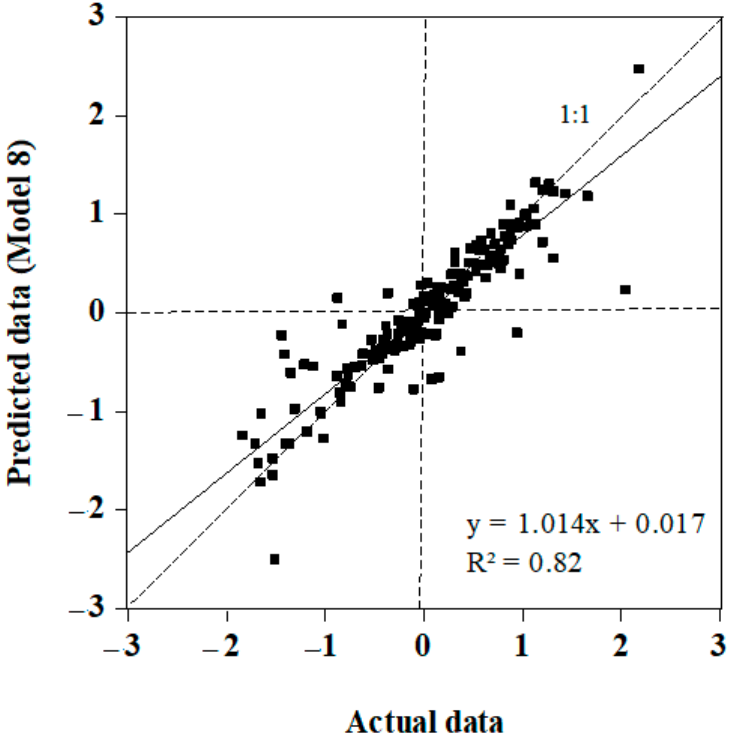
Figure 6. The best model for predicting the CTEI with the implementation of the support vector machine (SVM) algorithm—model 8. The residual plot for model 8 with the SVM method shows that the maximum errors in the CTEI predictions occurred in the range of 0 to 2 mm, as shown in Figure 7.